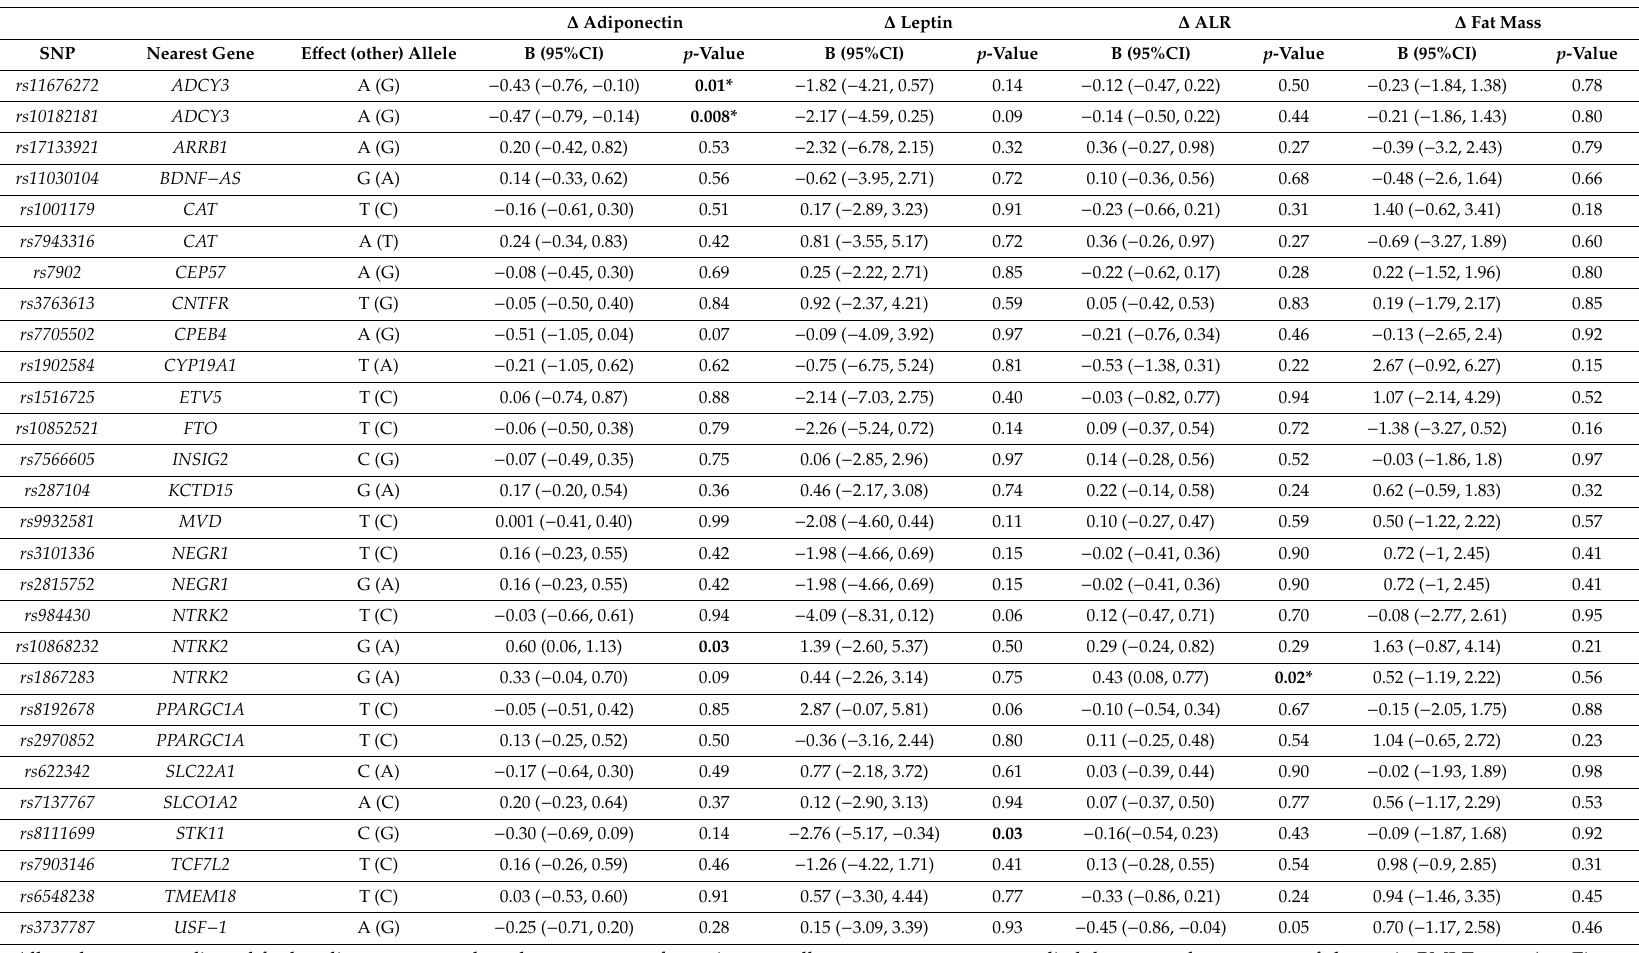
Table 4. Summary of association data for the 28 selected common variants in relation to adipokines and fat mass